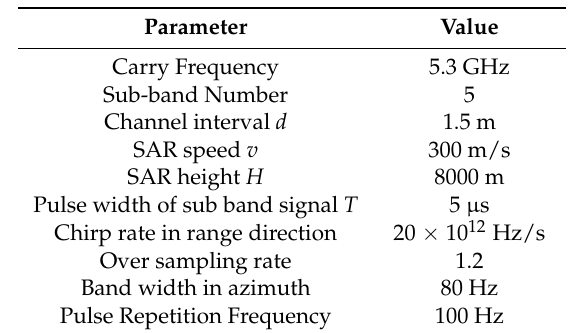
Table 1. Simulation